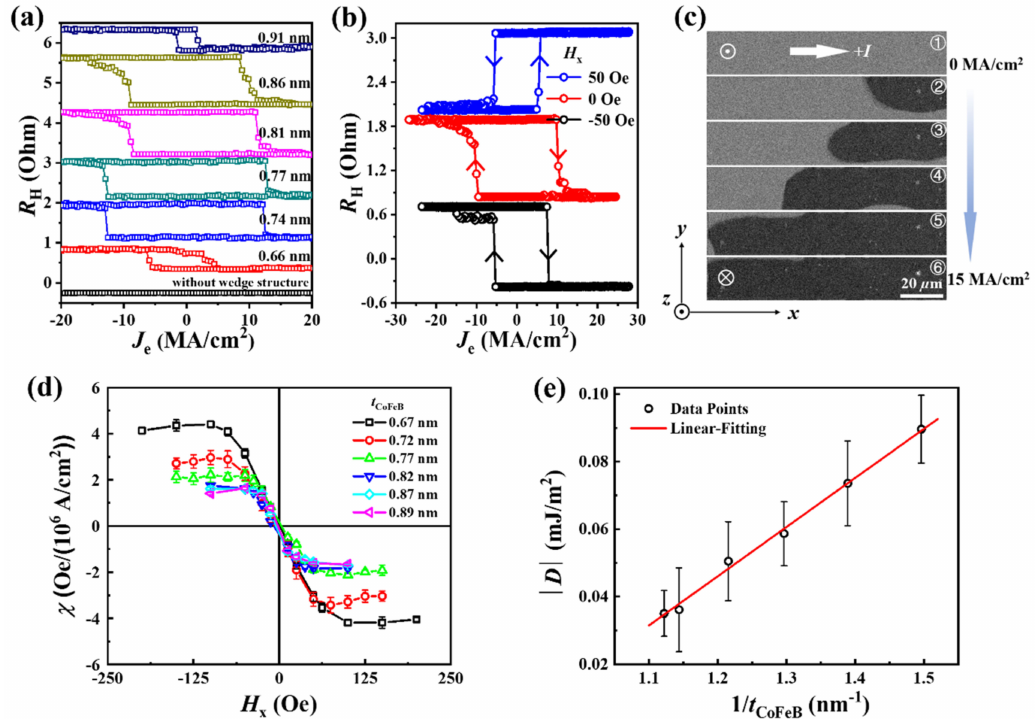
Figure 2. ( a ) Field-free SOT switching loops for the devices with different t CoFeB . ( b ) SOT switching at zero field and in-plane magnetic fields of H x = ± 50 Oe for the device with t CoFeB = 0.81 nm. ( c ) Representative MOKE images of pulsed current − driven magnetization switching for the whole Hall bar device with t CoFeB = 0.70 nm. ( d ) The measured SOT efficiency χ as a function of the in-plane magnetic field for different t CoFeB . ( e ) The relationship between the estimated DMI constant | D | and 1/ t CoFeB